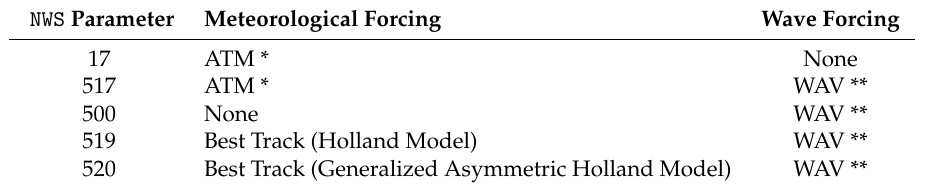
Table 2. New implemented and tested ADvanced CIRCulation model ( ADCIRC ) options. All model configurations and results are pre-decisional and for official use